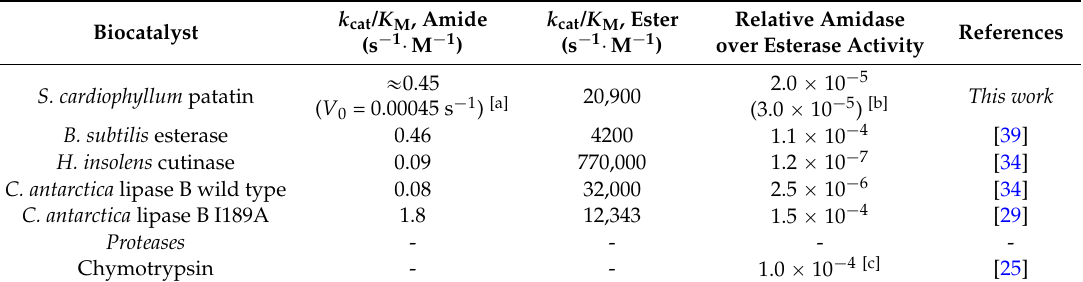
Table 2. Relative experimental promiscuous activities for patatin in comparison with other promiscuous esterases based on using p -nitrophenyl butyrate (ester) and p -nitrobutyranilide (amide) as